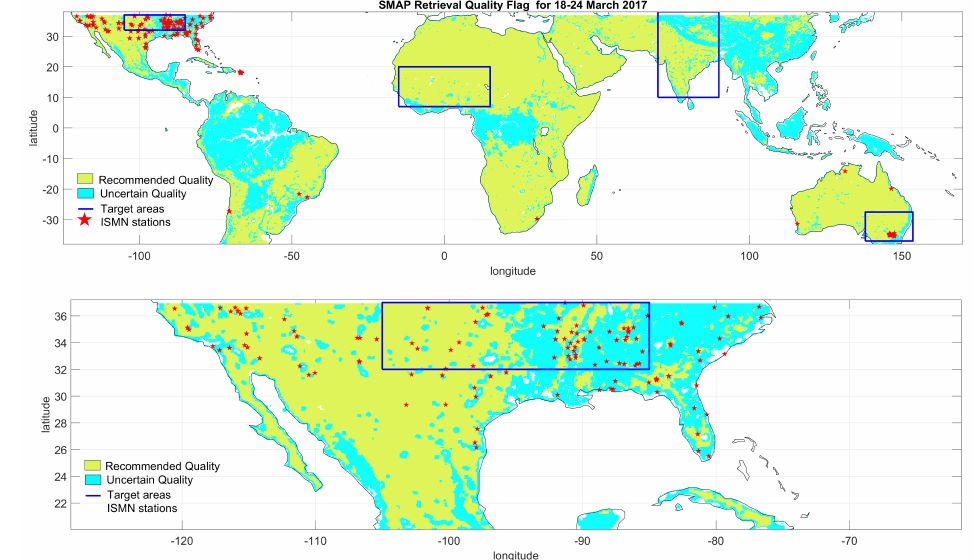
Figure 1. Soil Moisture Active Passive (SMAP) Retrieval Quality Flag (RQF) indicates whether soil moisture (SM) retrieval is recommended (green) or not recommended (cyan) over the specified location. Quality uncertain quality is influenced by factors such as water body fraction, coastal proximity, urban area, precipitation, terrain slope, and high vegetation water content. Red pentagrams show locations of International Soil Moisture Network (ISMN) stations. Blue boxes show target areas that are investigated in Section